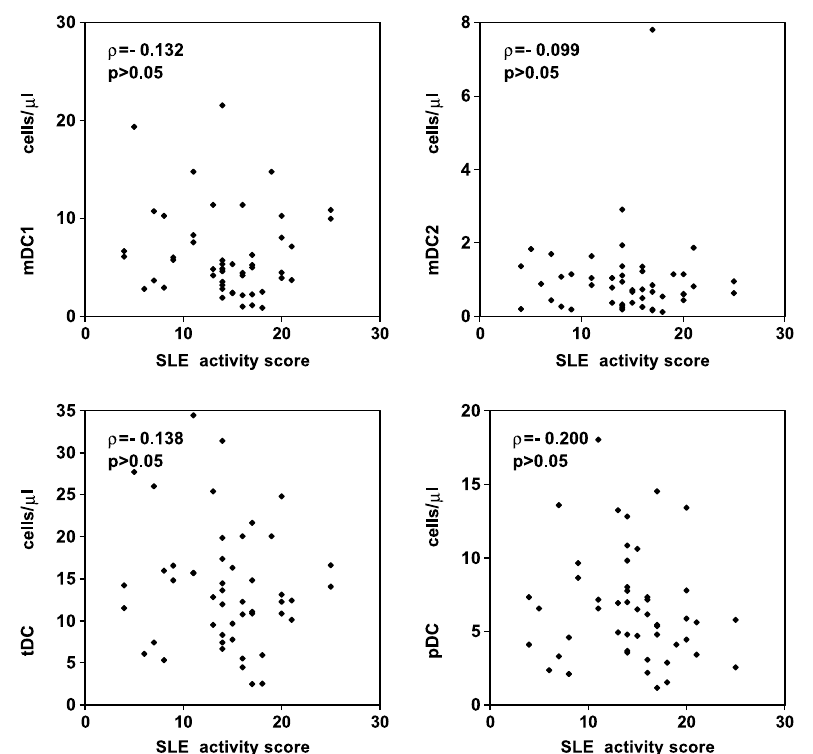
FIG. 5. Correlations between the disease activity score and number of total dendritic cells (tDC), pDC and mDC subpopulations in peripheral blood of SLE